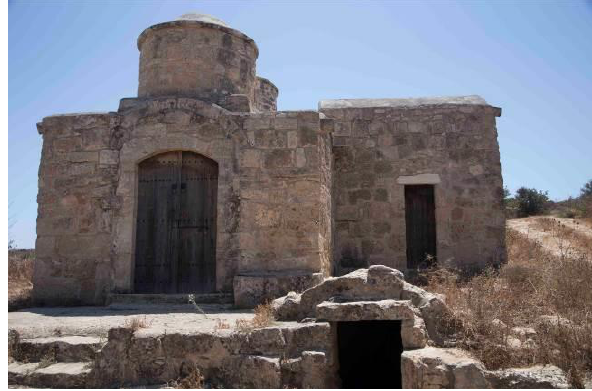
Figure 3: Church of Ayia Marina , Deryneia, Exterior Constraints and challenges such as strict rules established by the UN forces, limited working time available to perform the